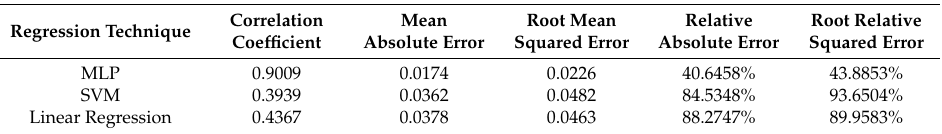
Table 4. Comparison of different regression techniques for BAC